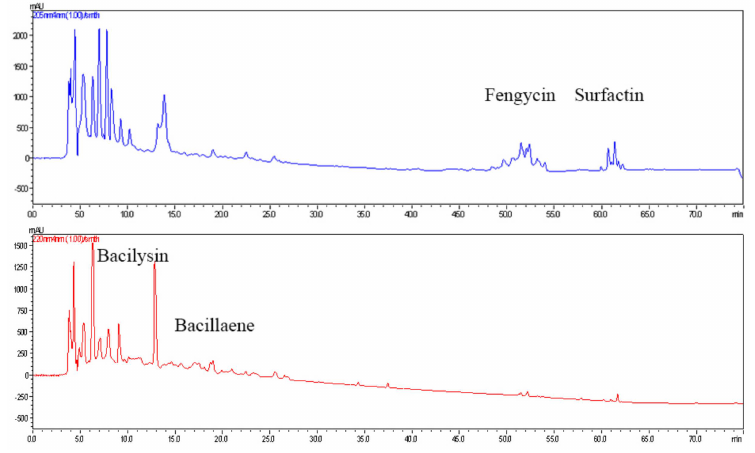
Figure 8. Ultra-performance liquid chromatography chromatograms of antifungal compounds produced by Bacillus subtilis L1-21.